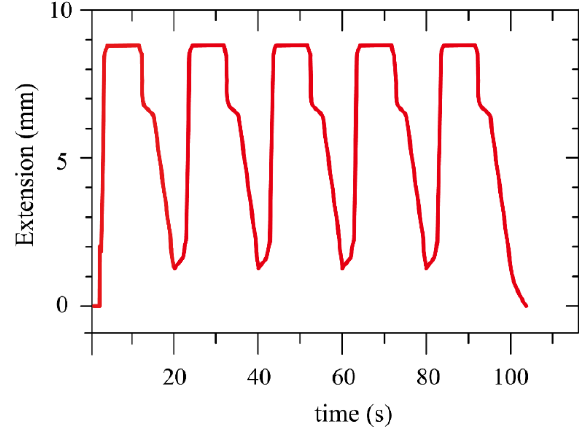
Figure 14. The extension response of the BSPA during several cycles. Within each period, the actuator achieved uncoiling and coiling motions consistently. Note that the actuator did not return to its original shape because the coiling motions needed more time to complete the retraction